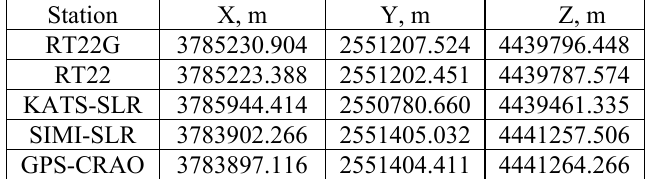
Table 1. Final solution for coordinates of points in the Simeiz-Katsively